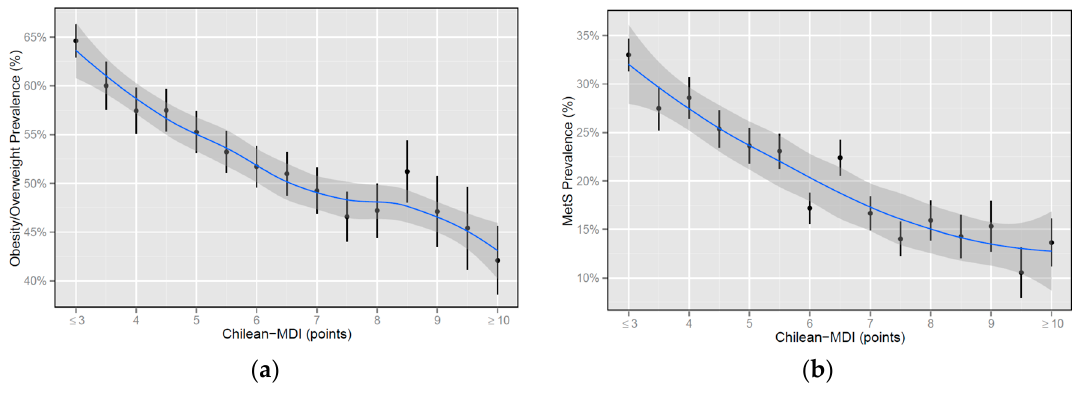
Figure 2. Overweight/obesity ( a ) and metabolic syndrome ( b ) prevalence by Chilean-MDI score. Standard error bars are shown for each data point. Prevalences were aggregated at end points due to small sample sizes. Smooth conditional prevalence was approximated by the curve with standard errors shaded in gray.